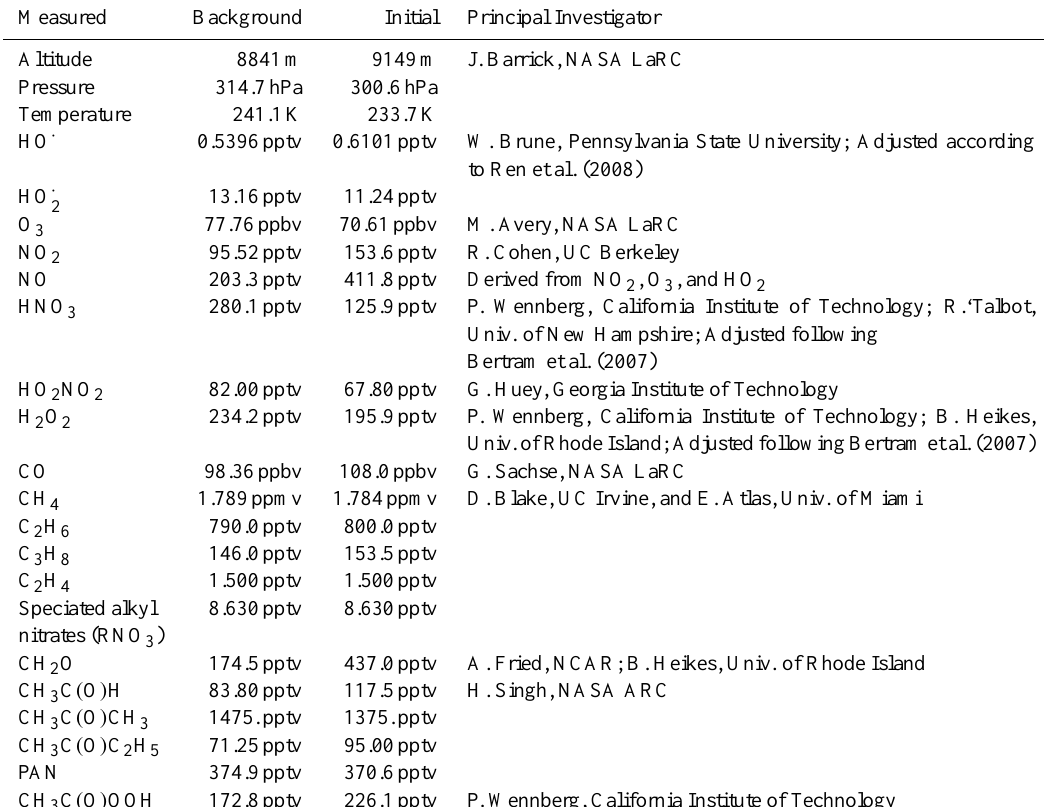
Table 2. Median observed values for filtered initial ( n i = 108) and background ( n bkg = 1006) selected chemical compounds and physical